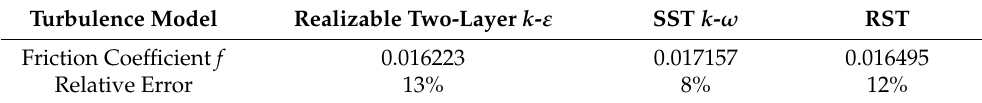
Table 4. Comparison of friction coefficient obtained by the different turbulent models.